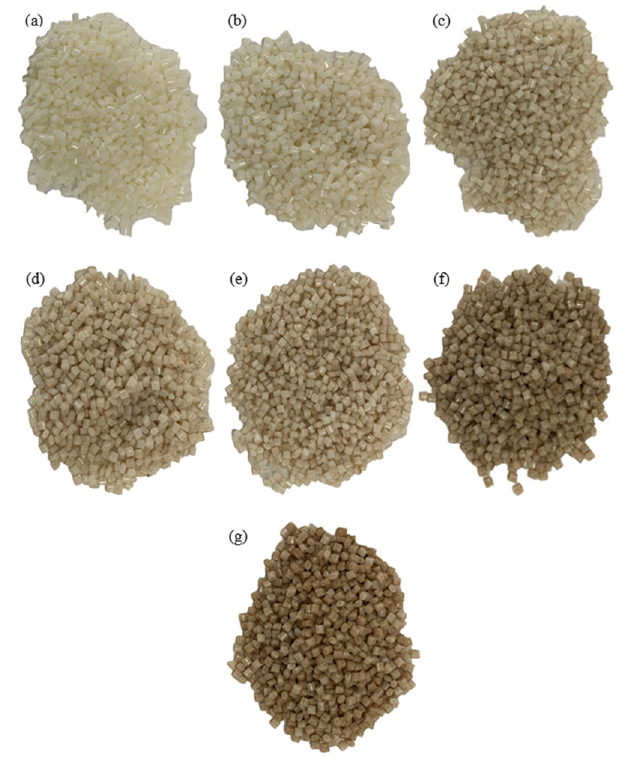
Figure 2. PLA pellets coated with sand particles, showing PLA-sand pellets with sand weight frac- tion of ( a ) 0 wt%, ( b ) 0.5 wt%, ( c ) 2 wt%, ( d ) 3 wt%, ( e ) 4 wt%, ( f ) 10 wt%, and ( g ) 15 wt%.